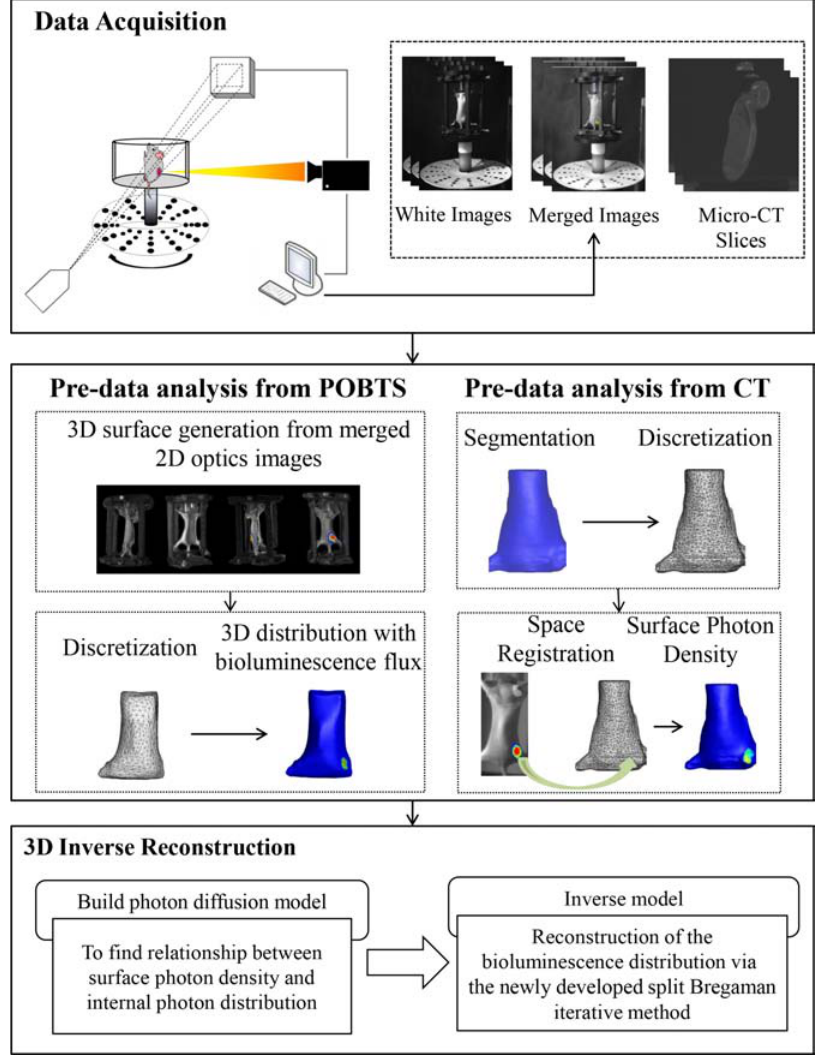
Fig. 1. The overview of the POBT and DMT techniques. Both POBT and DMT systems were intergrated in the same imaging platform and acquried data from the same xenograft. They both shared the same forward imaging model and inverse reconstruction algorithms in the ¯nal 3D inverse reconstruction. However, they had di®erent pre-data analysis procedures, and the POBTS simplied this process comparing with the DMT